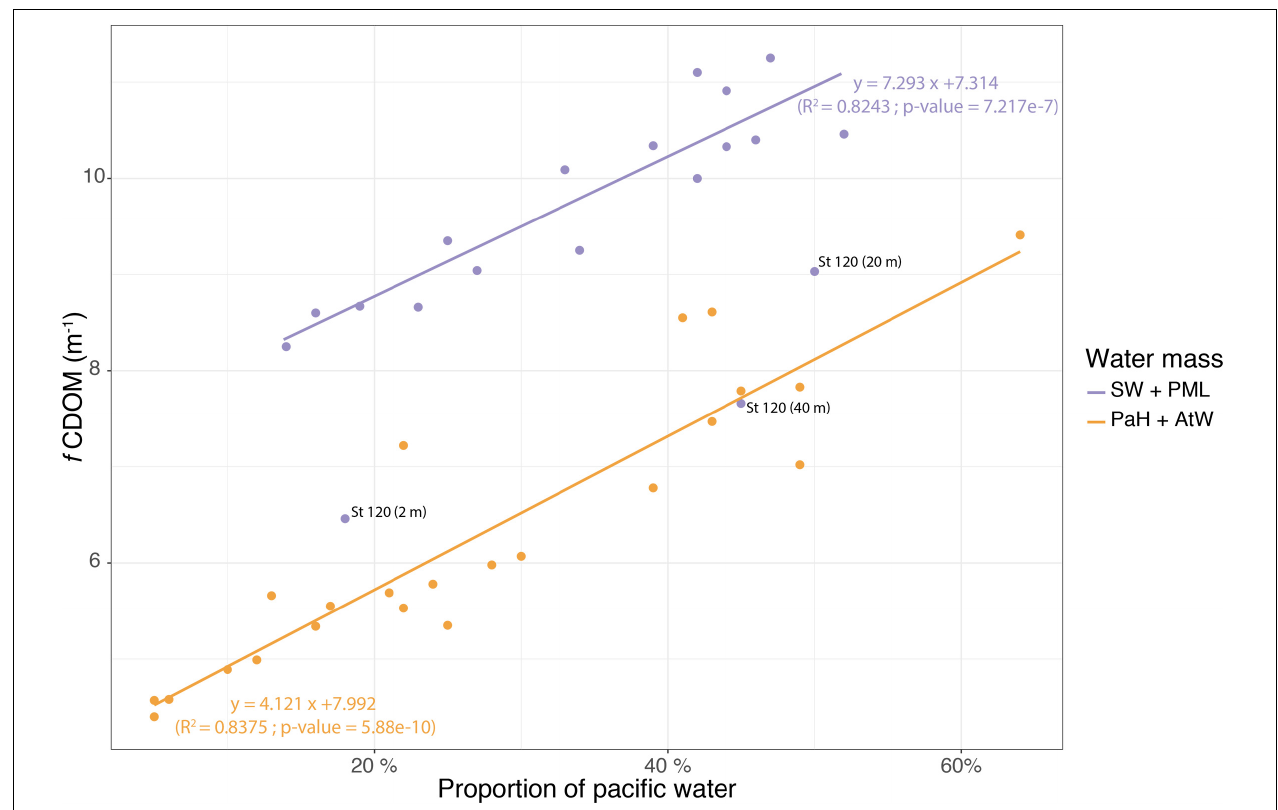
FIGURE 3 | Plot and linear regression of the f CDOM values against the calculated PW contribution in the surface (upper line) and deep layer (lower line) of the Nares Strait samples. The Stn. 120 values are indicated separately as gray